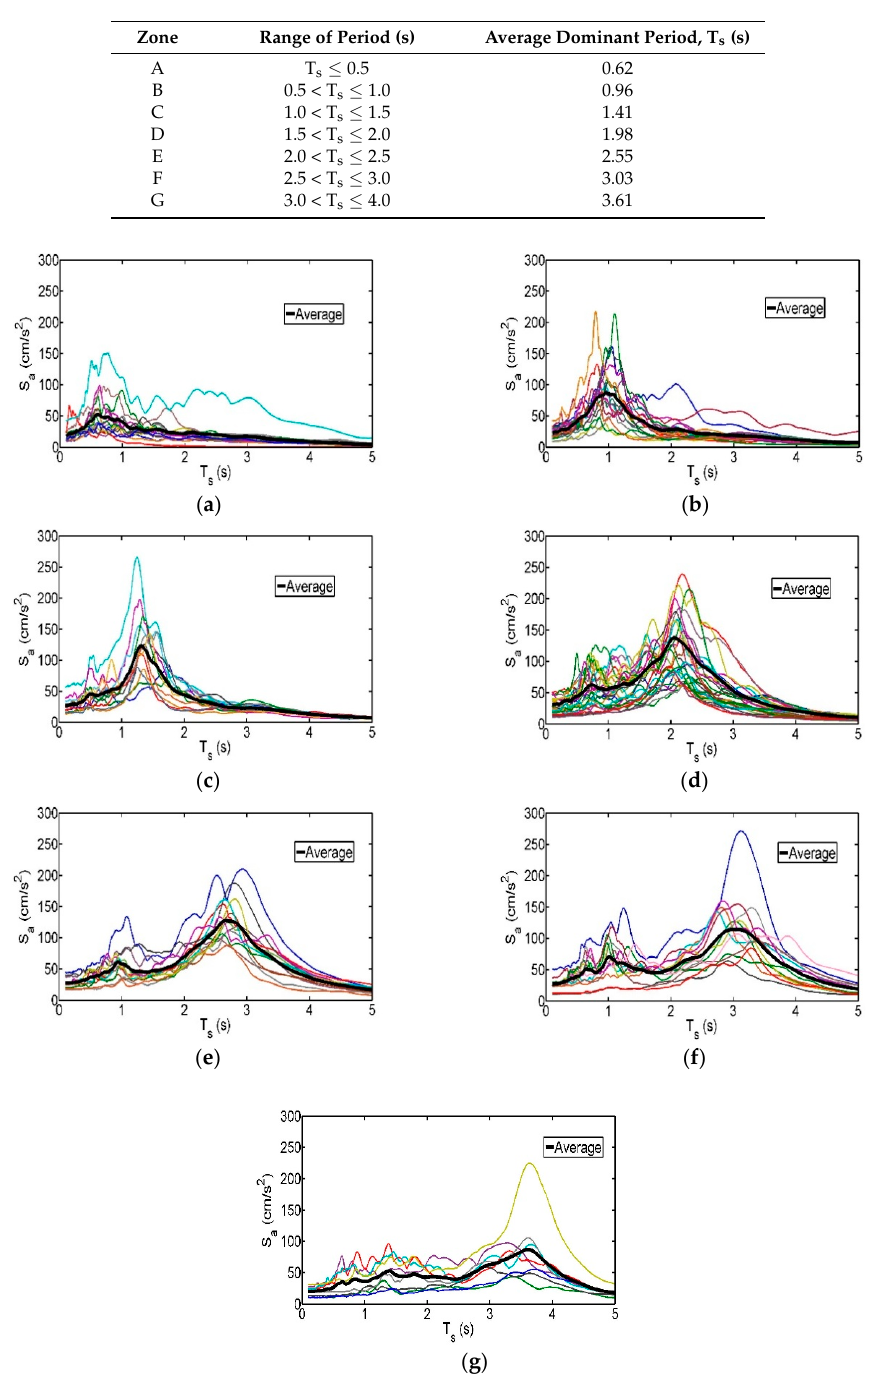
Table 1. Characterization of the valley of Mexico according to the dominant period of the soil.